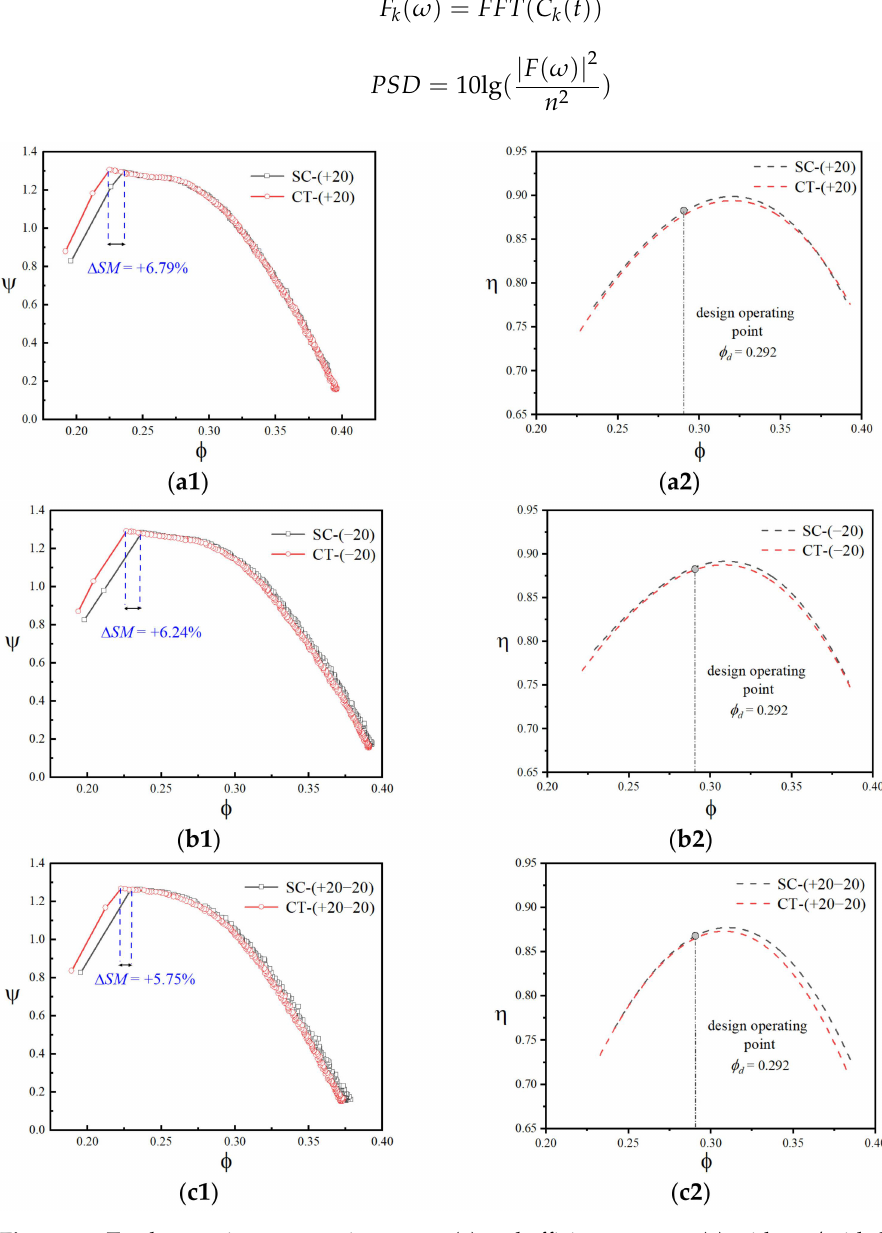
Figure 13. Total-to-static pressure rise curves ( 1 ) and efficiency curves ( 2 ) without/with SPS casing treatment under inlet swirl distortion of ( a ) +20, ( b ) − 20, and ( c ) +20 −